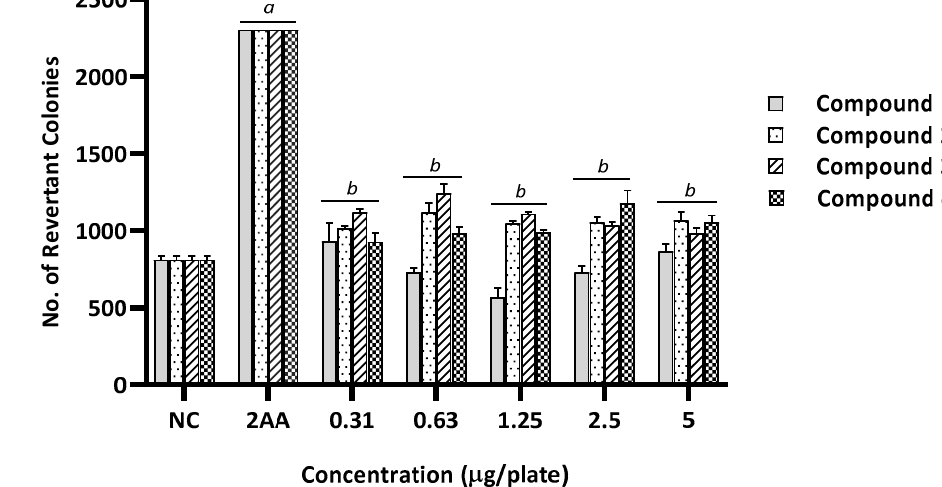
Figure 6. The number of revertant colonies of TA100 strain of Salmonella typhimurium treated with di ff erent concentration of benzimidazole derivatives (1–4) in the presence of metabolic activation system ( + S9). NC, Negative control (1% of DMSO in PBS); 2AA (2-aminoanthracene), Positive control (5 µ g / plate). Values were expressed as mean ± SEM of three independent experiments. a , significantly di ff erent ( p < 0.05) from the NC group; b , significantly di ff erent ( p < 0.05) from the positive control group